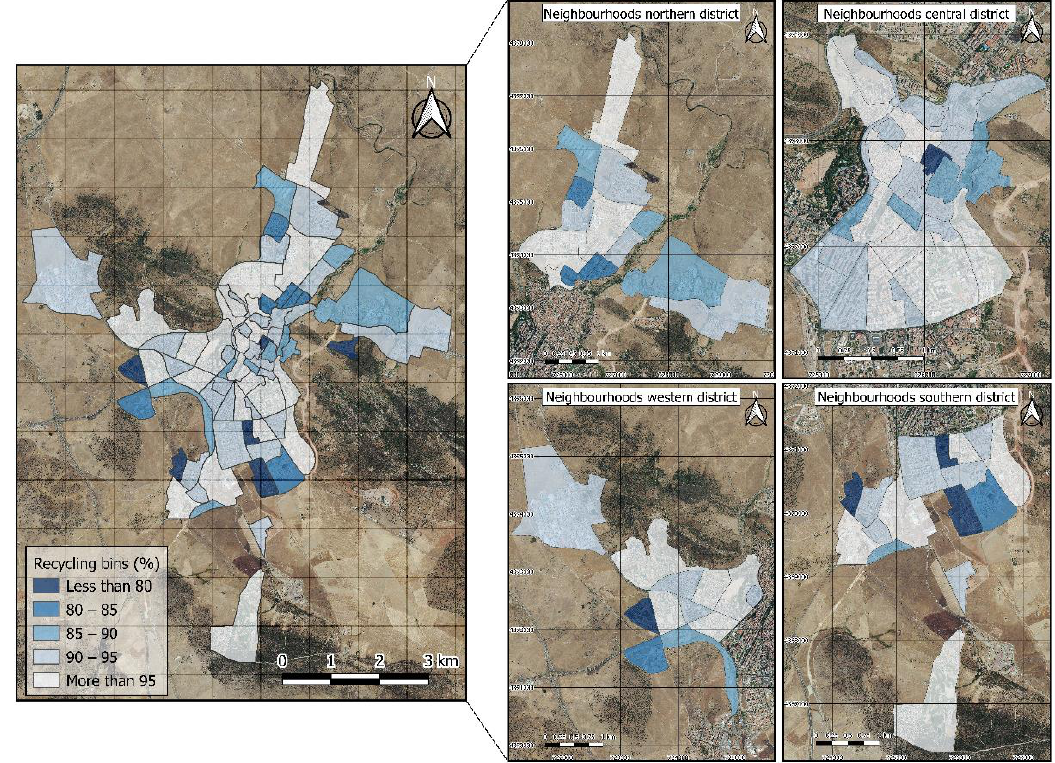
Figure 14. Urban land at more than 100 meters from a recycling bin.